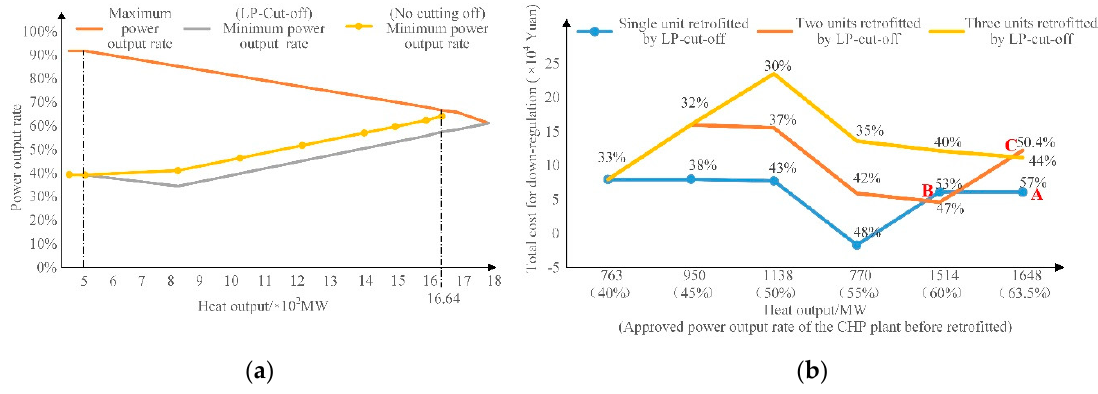
Figure 4. ( a ) Effect of cutting off Low Pressure (LP) turbine of unit No. 2 on electric power rate of the Figure 4. ( a ) E ff ect of cutting o ff Low Pressure (LP) turbine of unit No. 2 on electric power rate of the CHP plant; ( b ) effect of cutting off Low Pressure (LP) turbines of multiple units on the CHP plant. CHP plant; ( b ) e ff ect of cutting o ff Low Pressure (LP) turbines of multiple units on the CHP